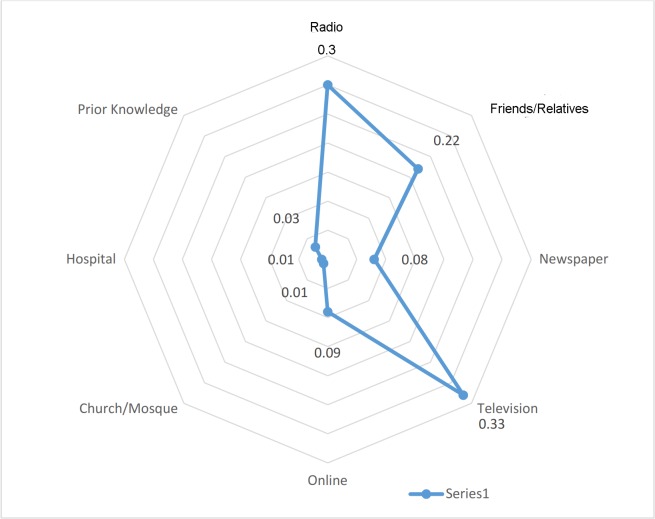
Respondents’ source of knowledge on EBV.